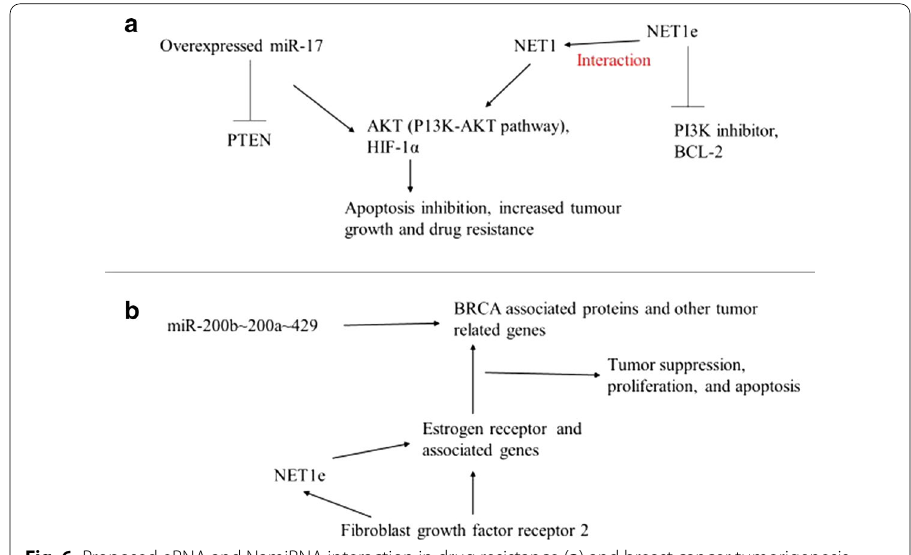
Fig. 6 Proposed eRNA and NamiRNA interaction in drug resistance ( a ) and breast cancer tumorigenesis ( b ). During drug resistance, overexpressed miR-17 represses PTEN leading to the activation of the PI3K-Akt pathway and HIF-1α. Simultaneously, Net1e increases the expression of NET1 while inhibiting the PI3K inhibitor and BCL-2. NET1 and NET1e interact with miR-17 via the PI3K-Akt pathway to inhibit apoptosis and increase tumor growth, while NET1 causes induced drug resistance ( a ). In breast cancer, fibroblast growth factor receptor 2 interacts with NET1e, the Estrogen receptor (ER), to regulate BRCA and other cancer genes, which are targets of miR-200b ~ 200a ~ 429. These trigger an interaction between miR-200b ~ 200a ~ 429, ER, NET1e, and ER-associated genes leading to tumor suppression, increased proliferation, and inhibited apoptosis in breast cancer